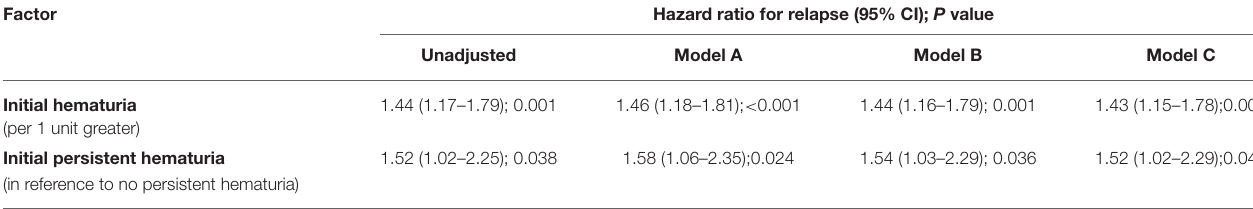
TABLE 2 | Microhematuria and risk of relapse in cox proportional hazards models.